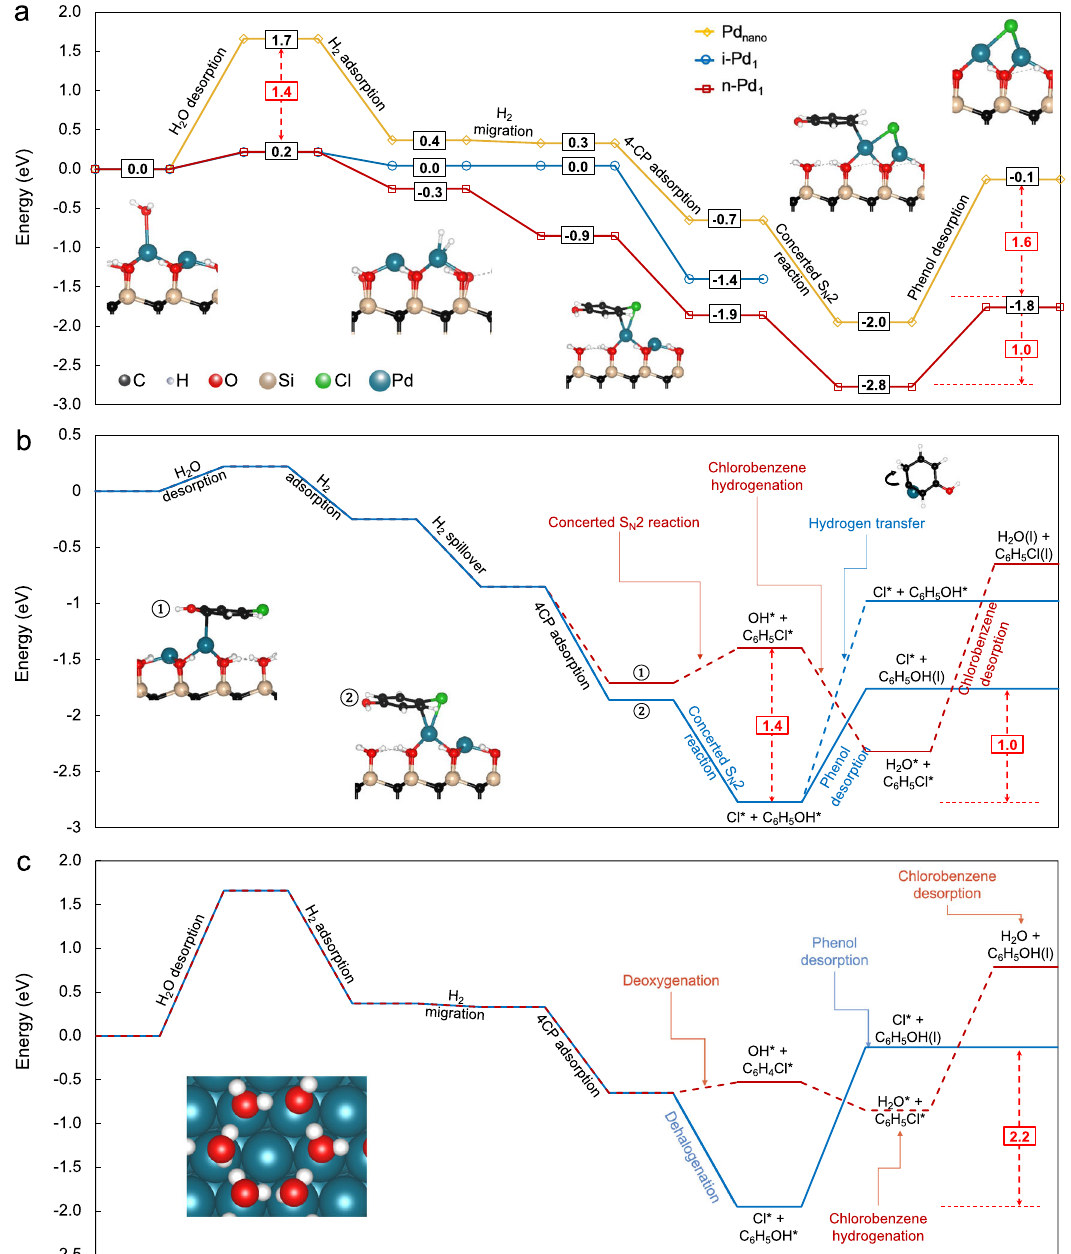
Fig. 3 DFT-calculated minimum energy pathway of 4-CP hydrogenation. a Hydrodehalogenation on i-Pd 1 , n-Pd 1 , and Pd nano . All steps are exothermic except for H 2 O, phenol, and Cl − desorption (not calculated here). b Alternative 4-CP hydrogenation pathways on n-Pd 1 (i.e., C-O bond cleavage